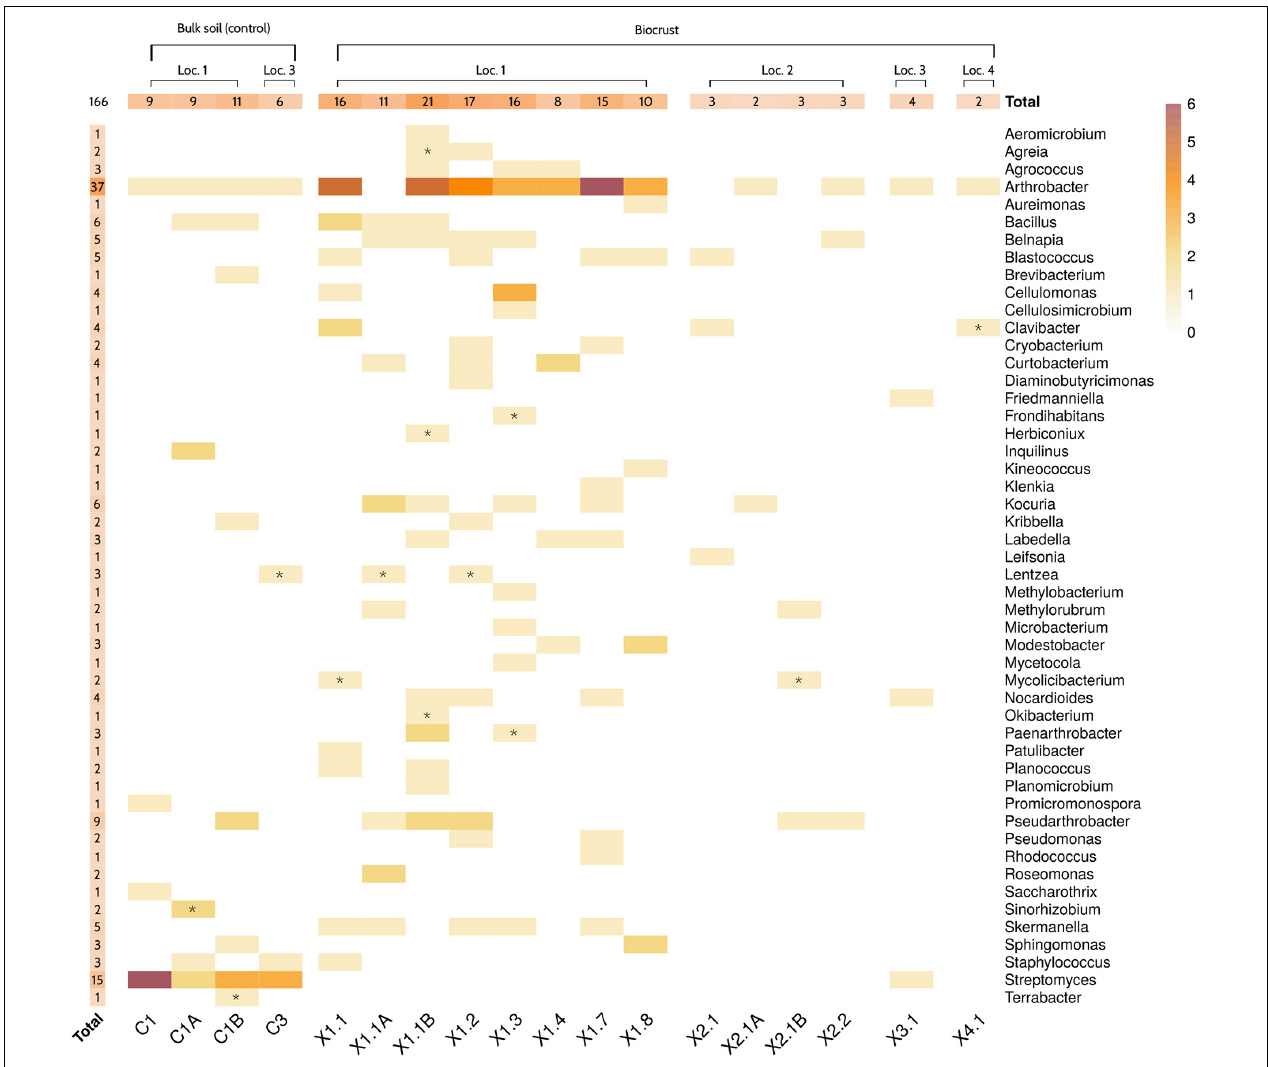
FIGURE 4 | Culture collection description. Heatmap showing the number of strains isolated from each sample. Genus-level taxonomy of the strains was obtained by partial 16S rRNA gene sequencing of isolates. Letters “A” and “B” indicate the samples that were collected on the third day, after analyzing the original samples by Nanopore sequencing. Symbol “*” highlights those genera that were not originally detected in that sample by in situ sequencing. Only genera with a relative abundance higher than 0.001% were considered as detected. Samples 3.2 and 6.2 are not shown, since no bacterial strain was isolated from them. Loc,